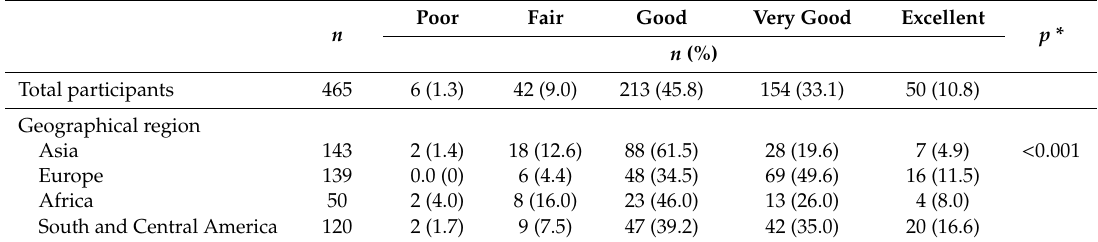
Table 2. Self-perceived health status classified by geographical